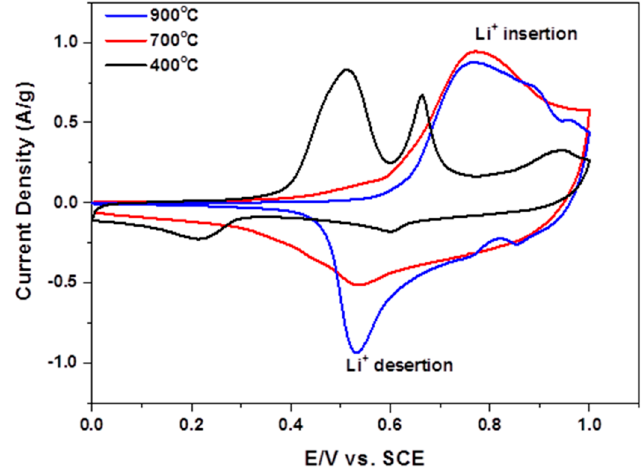
Figure 8. Cyclic voltammetry test of LiCoO 2 calcined at 400 °C, 700 °C, and 900 °C. SCE: Saturated calomel electrode.